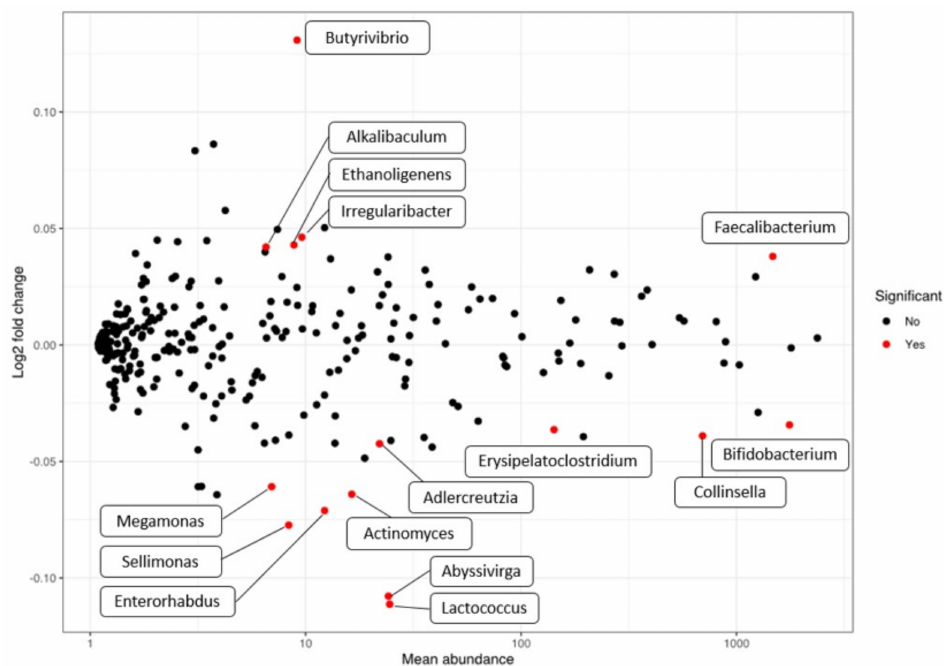
Figure 4. Correlation between SCORAD index and